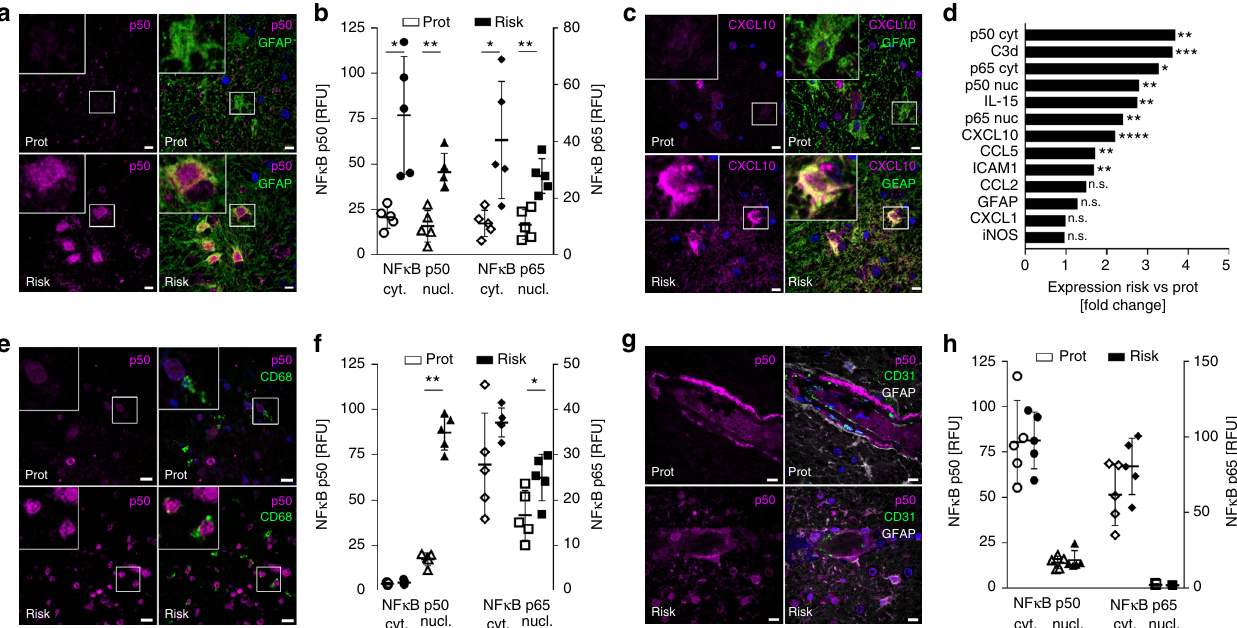
Fig. 4 Effect of the rs7665090 G variant on NF- κ B signaling in white matter MS lesions. a Confocal microscopy images of hypertrophic astrocytes at the lesion edge, labeled with fl uorescent antibodies against p50 (magenta) and GFAP (green) and counterstained with Hoechst 33342. b Densitometric quanti fi cation of NF- κ B p50 and p65 in the cytosol/nucleus of hypertrophic lesional astrocytes (5 cases per group). c Hypertrophic astrocytes stained with fl uorescent antibodies against CXCL10 (magenta) and GFAP (green) and counterstained with Hoechst 33342. d Differential expression of immune mediators and activation markers in astrocytes from both groups. e Activated microglia at the lesion edge labeled with fl uorescent antibodies against p50 (magenta) and CD68 (green) and counterstained with Hoechst 33342. f Densitometric quanti fi cation of NF- κ B p50 and p65 in the cytosol/nucleus of activated microglia (5 cases per group). g Endothelial cells at the lesion edge labeled with fl uorescent antibodies against p50 (magenta) and CD31 (green) and counterstained with Hoechst 33342. h Densitometric quanti fi cation of NF- κ B p50 and p65 in the cytosol/nucleus of endothelial cells (5 cases per group). Data represent means ± s.d. p -Values shown for the post-hoc Tukey – Kramer test after one-way ANOVA, * p < 0.05 and ** p < 0.01. Scale bars